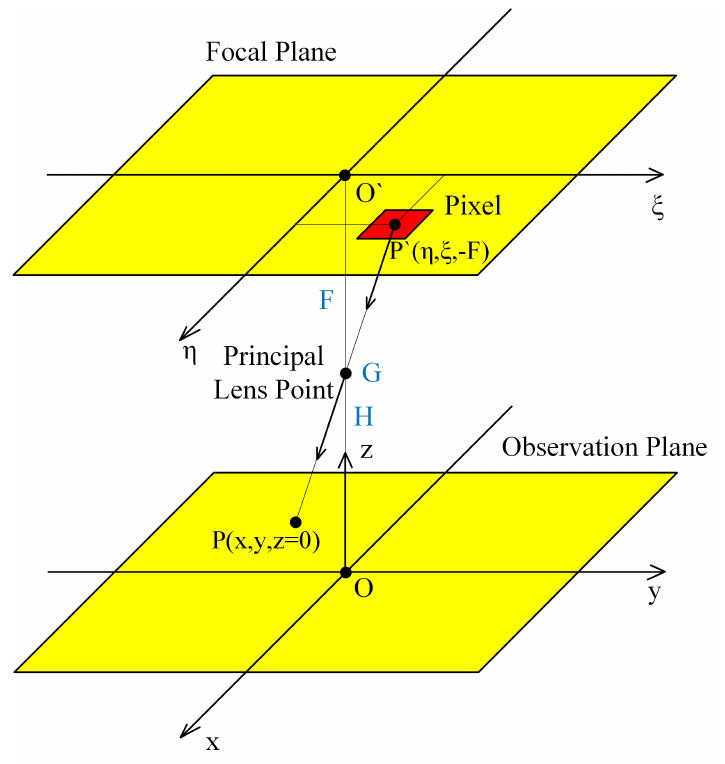
Figure 1. The picture shows the projection of the image plane onto the earth surface. The orientation of the line of sight is changing by rotation at point G.